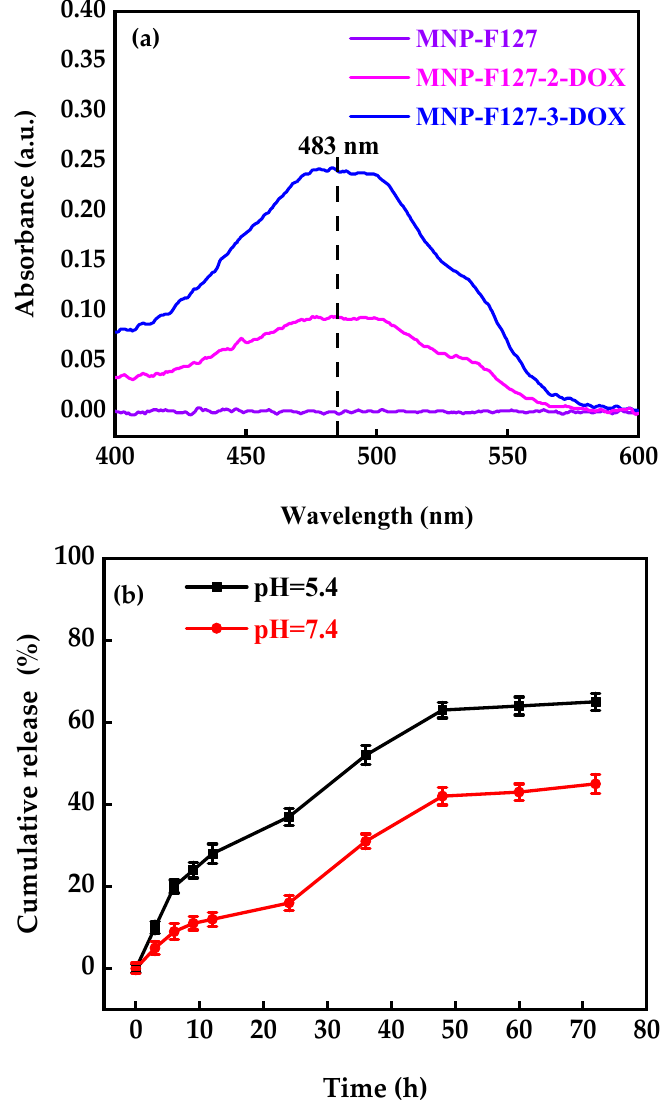
Figure 5. ( a ) UV-Vis spectra and ( b ) in vitro release profile of MNP-F127-3-DOX under different pH values (pH = 5.4 and 7.4) at 37 °C.